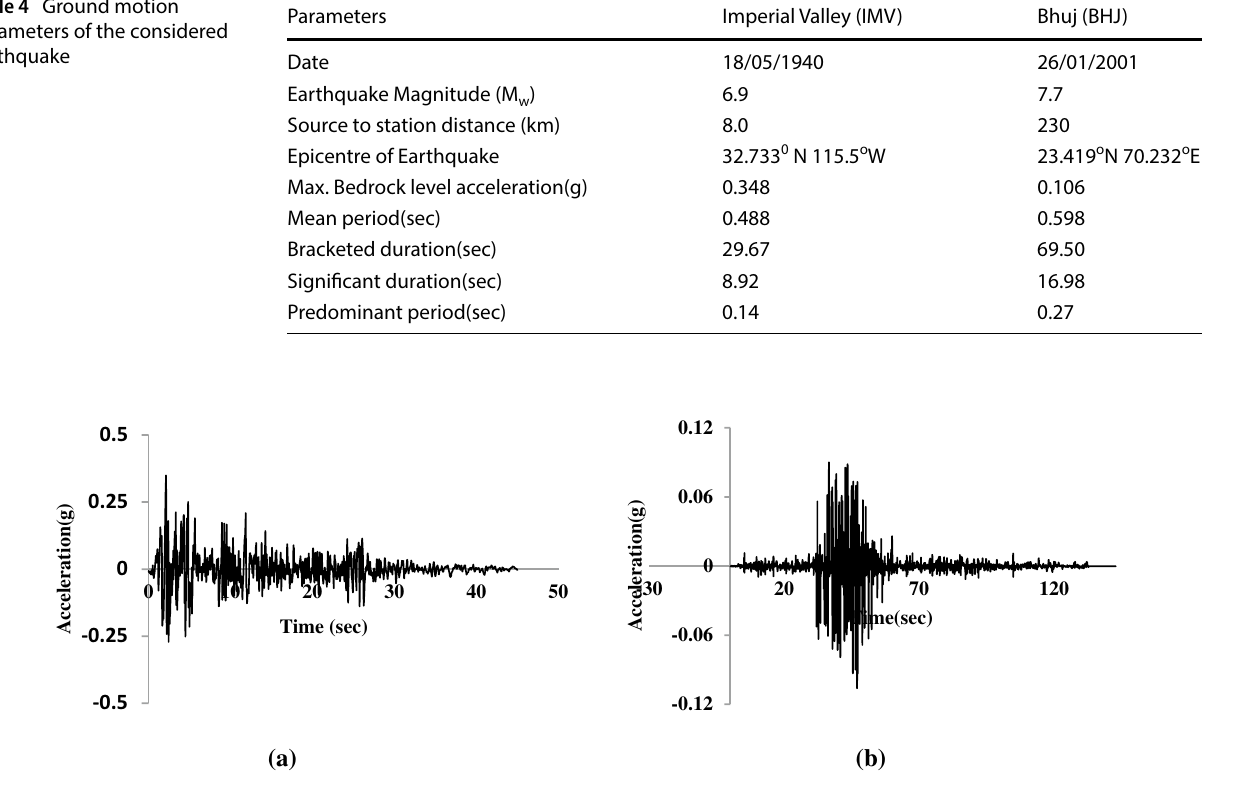
Fig. 1 Acceleration time-history of a IMV and b BHJ earthquake